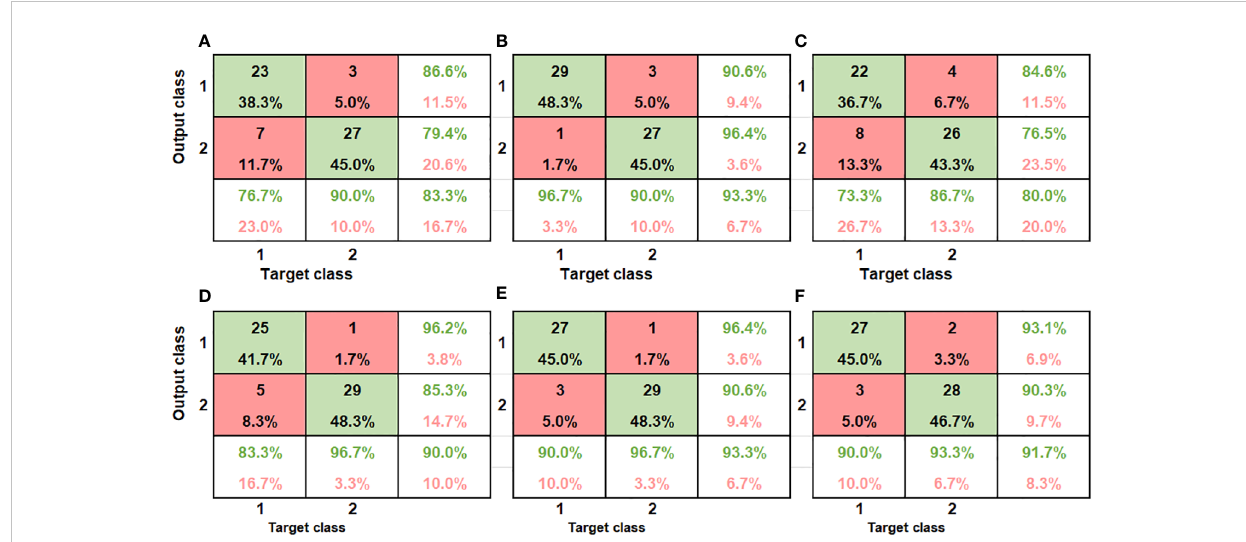
FIGURE 9 The confusion matrix of the classi fi cation performance of the different class groups using the SWIR camera (SI (A) , SII (B) , and SIII (C) , and VNIR SI (D) , SII (E) and SIII (F) . The x axis refers to the true categories, and the y axis refers to the classi fi er outputs. The integers in the matrix show several samples. The color encodes the percentage of a class of blocks (x) classi fi ed into a predicted class (y).